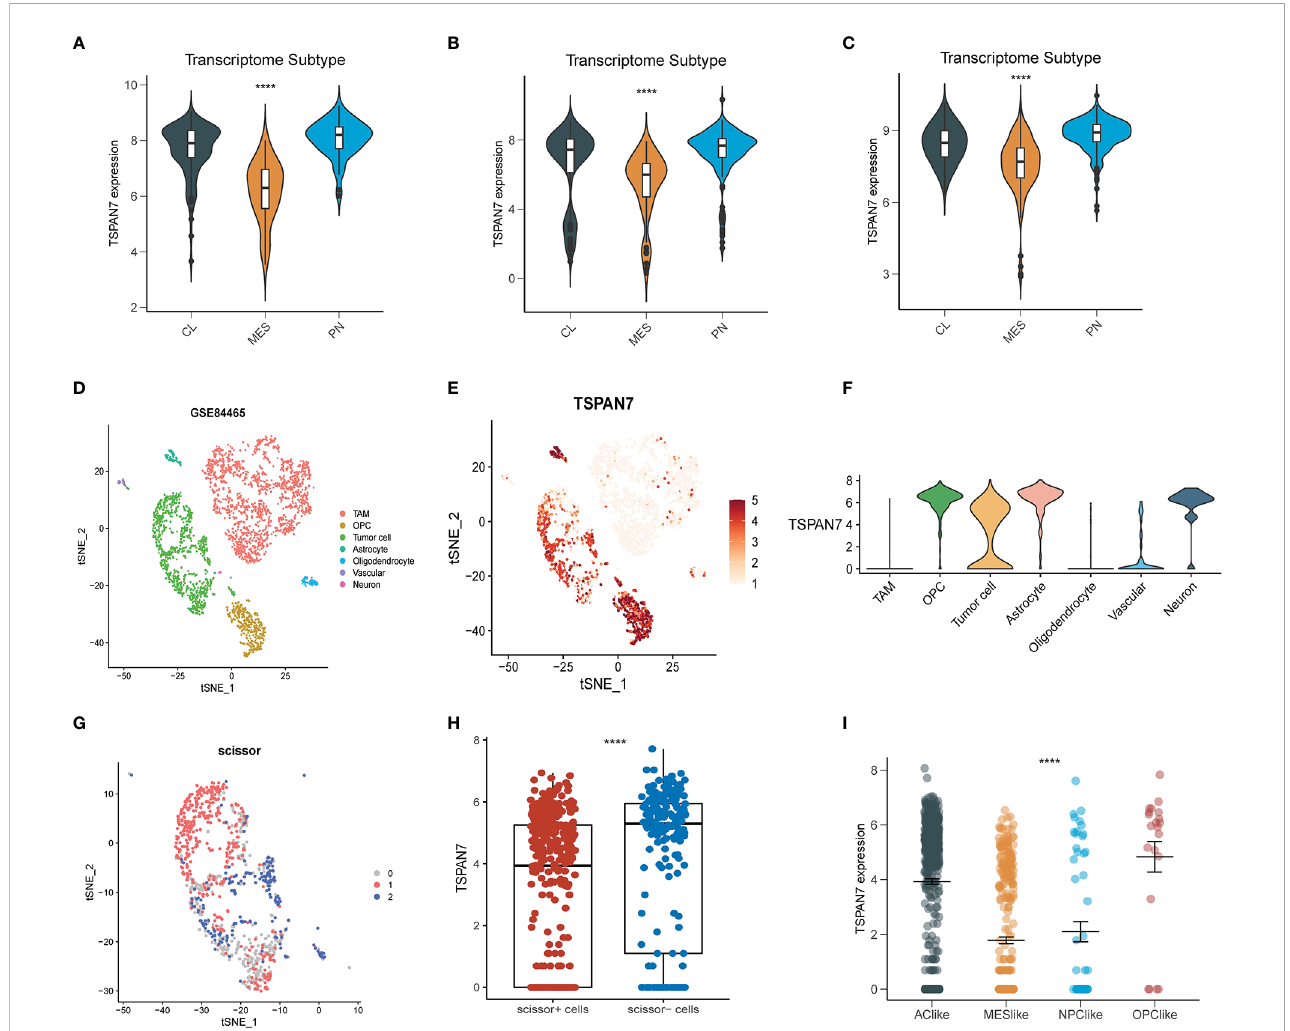
FIGURE 2 The expression of TSPAN7 in different glioma subtypes (A-C) TSPAN7 expression level in different molecular subtypes in CGGA_325, CGGA_691 and TCGA datasets based on bulk expression. (D-E) The cells were categorized into seven clusters and scatter plots represent TSPAN7 expression distribution in seven clusters. (F) The expression of TSPAN7 in seven clusters. (G) single cell was divided into Scissor+ cell or Scissor- cell 3 groups according to the prognosis by scissor algorithm. (H) The expression of TSPAN7 in Scissor+ cell and Scissor- cell. (I) Tumor cells were extracted and categorized into four different cell clusters based on scRNA expression level. ****p